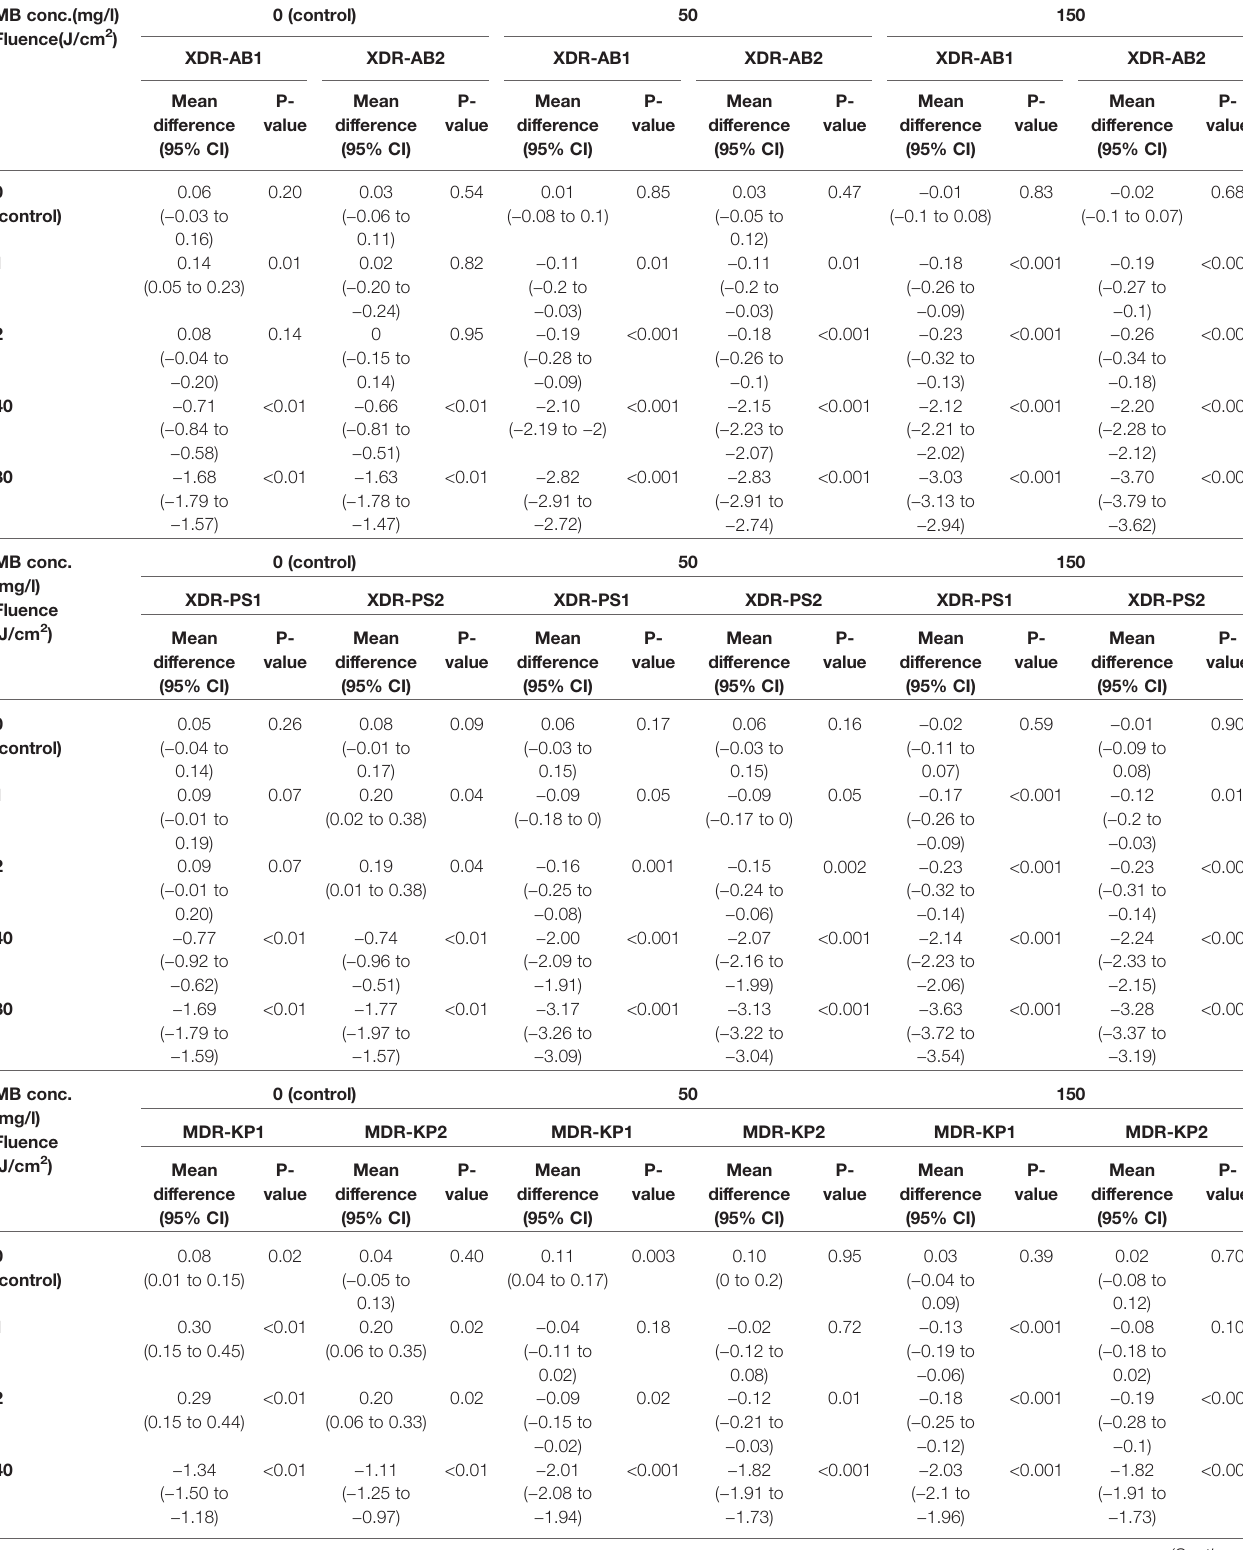
TABLE 1 | Mean log 10 difference of MB-aPDT group for XDR-AB, XDR-PS, and MDR-KP compared with baseline. MB conc.(mg/l) Fluence(J/cm 2